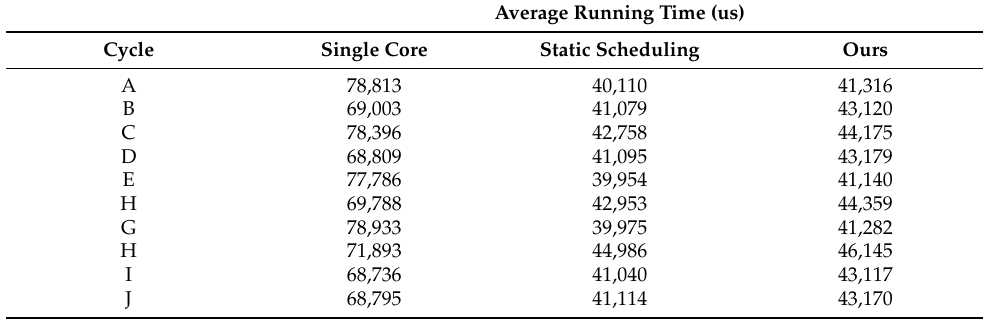
Table 9. Running time comparison for application